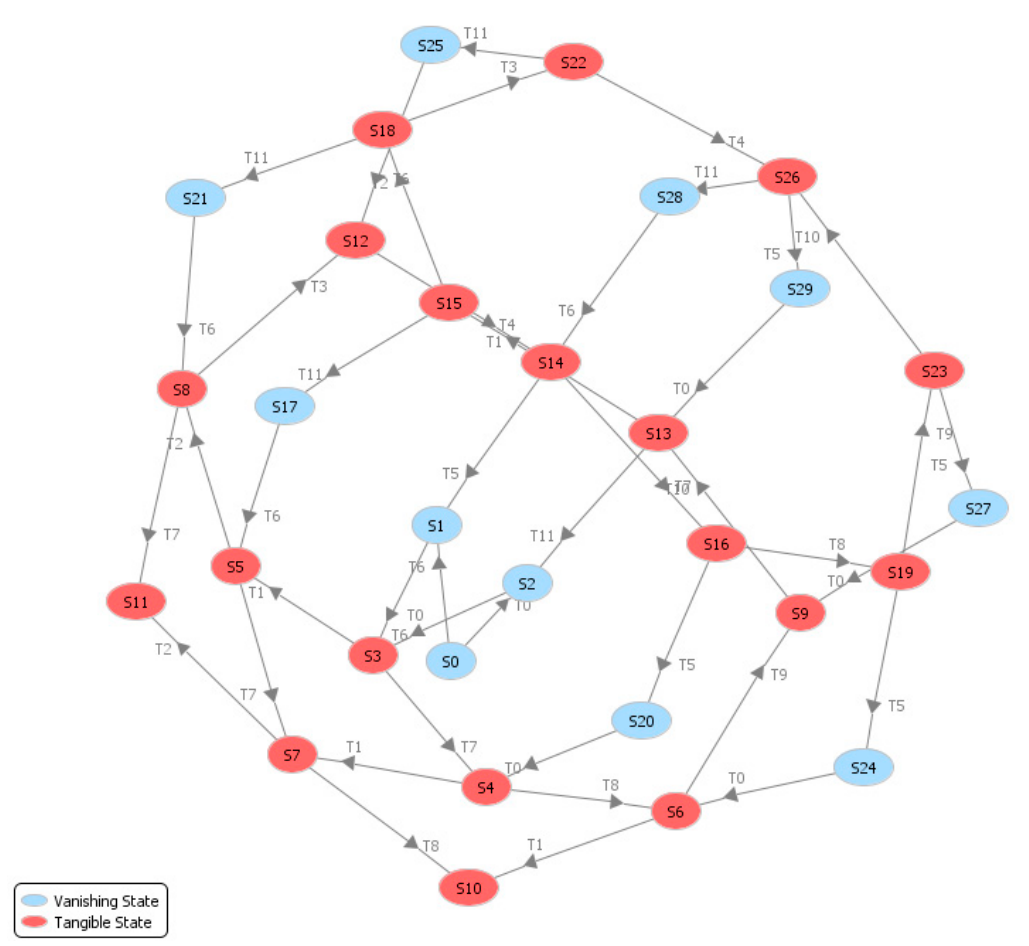
Figure 17. Case IV: reachability/coverability graph obtained by PIPE simulator.